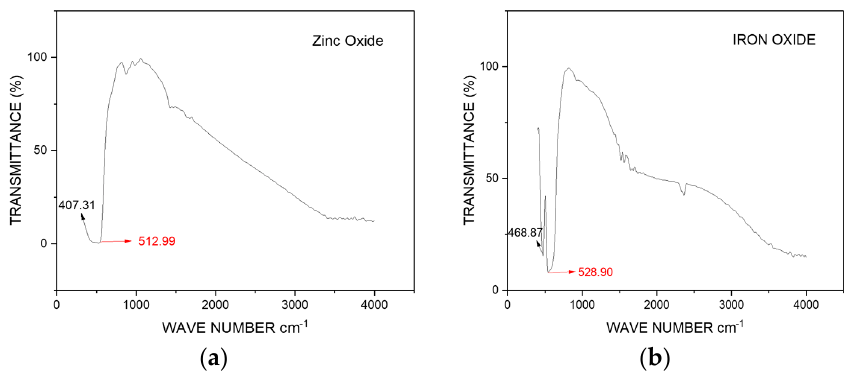
Figure 6. ( a ) FTIR result of zinc oxide; ( b ) FTIR result of iron oxide.